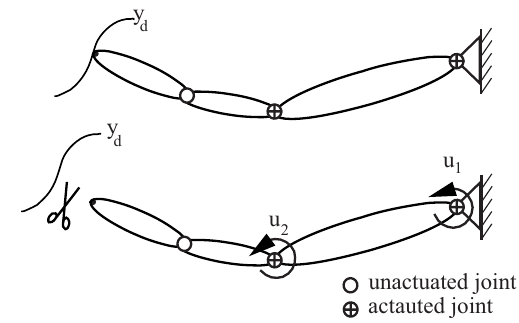
Figure 2. Multibody systems with